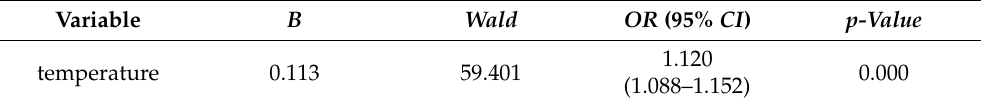
Figure 1. Effects of temperature on the development and reproduction of S. caerulea . ( a ) Number of eggs laid (the eggs were laid by two females during 24 h). ( b ) Parasitism rates. ( c ) Developmental duration. ( d ) Number of emerged adults. ( e ) Female ratio. ( f ) Adult life span. means ± standard errors, the different letters indicate significant differences amongst the temperatures (female, capital letters; male, lowercase letters) ( p < 0.05), and * indicates significant differences between females and males at the same temperatures ( p < 0.05). Table 1. Logistic regression analysis of the effect of temperature on S. caerulea ’s parasitism.